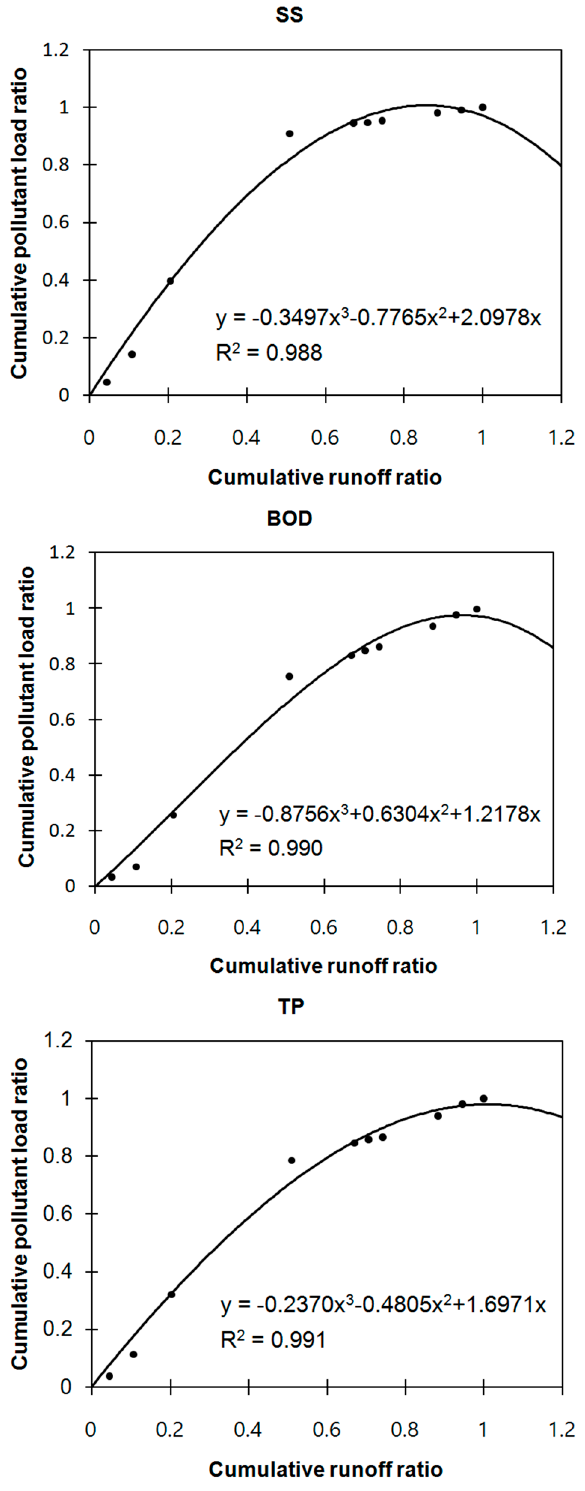
Figure 12. M(V) curve fitting using the third-degree polynomial function for Naedongcheon (16–17 July 2016).